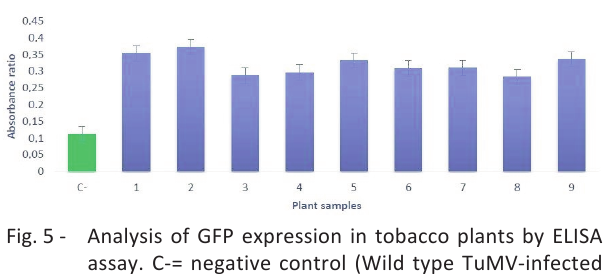
Fig. 5 - Analysis of GFP expression in tobacco plants by ELISA assay. C-= negative control (Wild type TuMV-infected plant), 1-3= Nicotiana benthamiana transformed plants, Lane 4-9= N. tabacum transformed plants. The data represent means ± SE from five independent infected